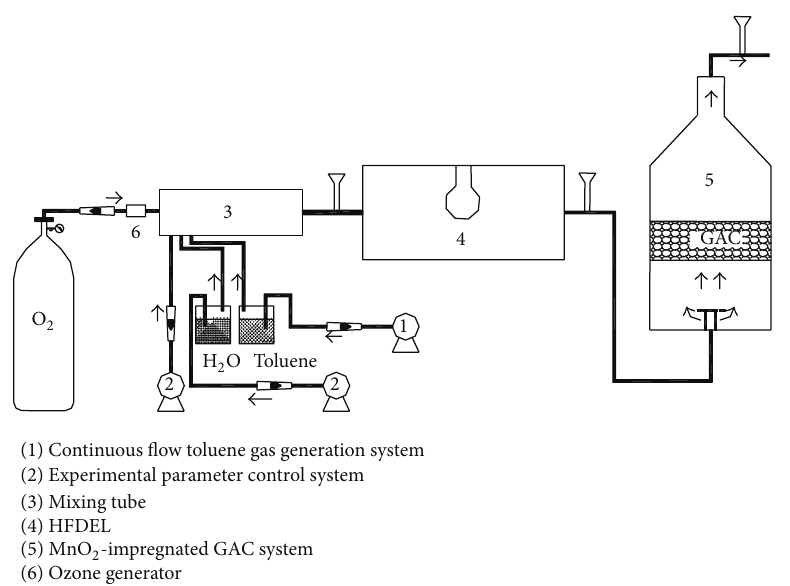
Figure 1: The sketch of experimental setup of the combination of HFDEL with MnO 2 -impregnated GAC